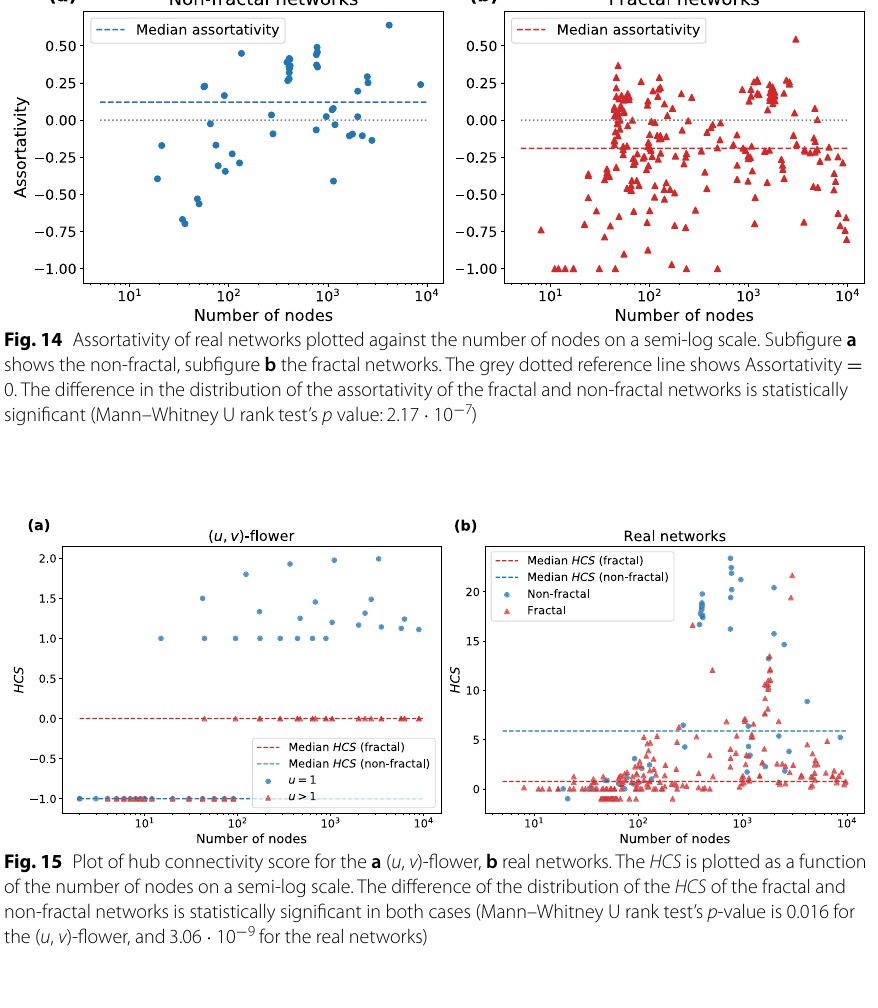
Fig. 15 Plot of hub connectivity score for the a ( u , v )‑flower, b real networks. The HCS is plotted as a function of the number of nodes on a semi‑log scale. The difference of the distribution of the HCS of the fractal and non‑fractal networks is statistically significant in both cases (Mann–Whitney U rank test’s p ‑value is 0.016 for the ( u , v )‑flower, and 3.06 · 10 − 9 for the real